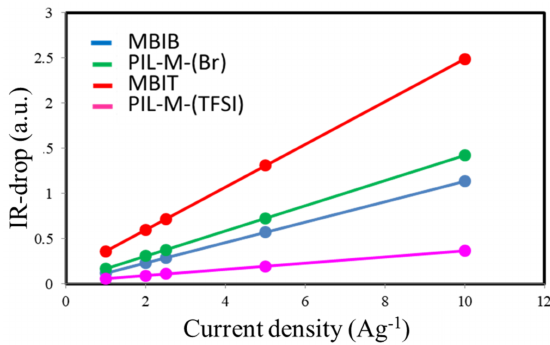
Figure 10. Plot of IR-drop against current density for ILs and PIL-IL blends.